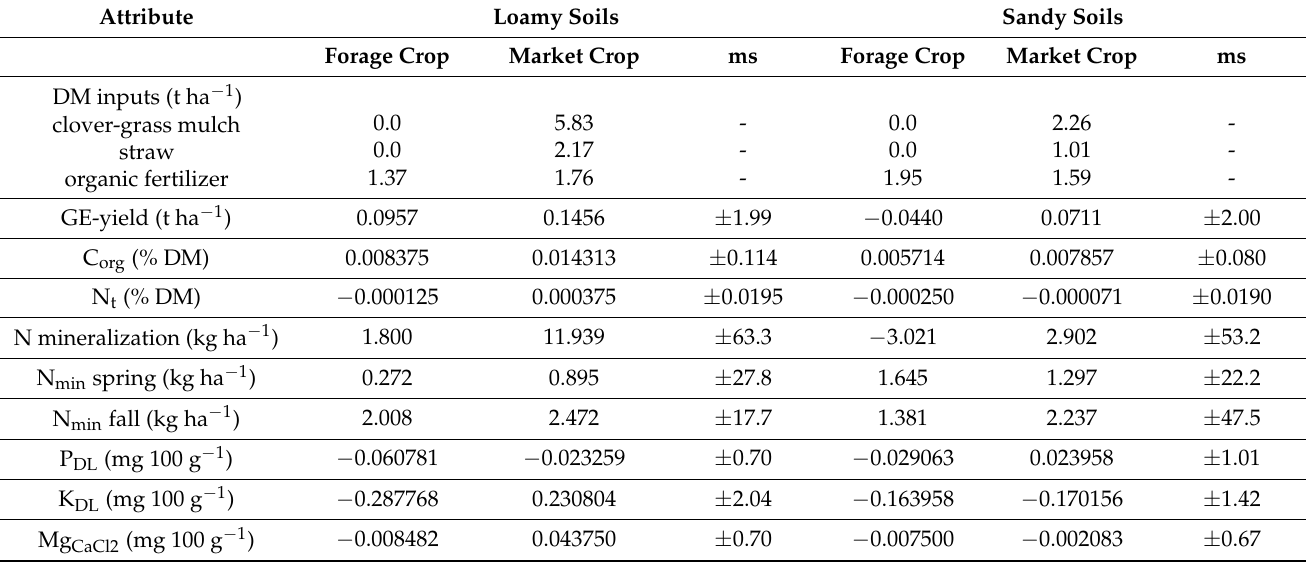
Table 8. Effect of the supply of organic materials in variants with organic fertilization corresponding to 1.0 LU ha − 1 on the annual change of certain characteristics from long-term trials of loamy